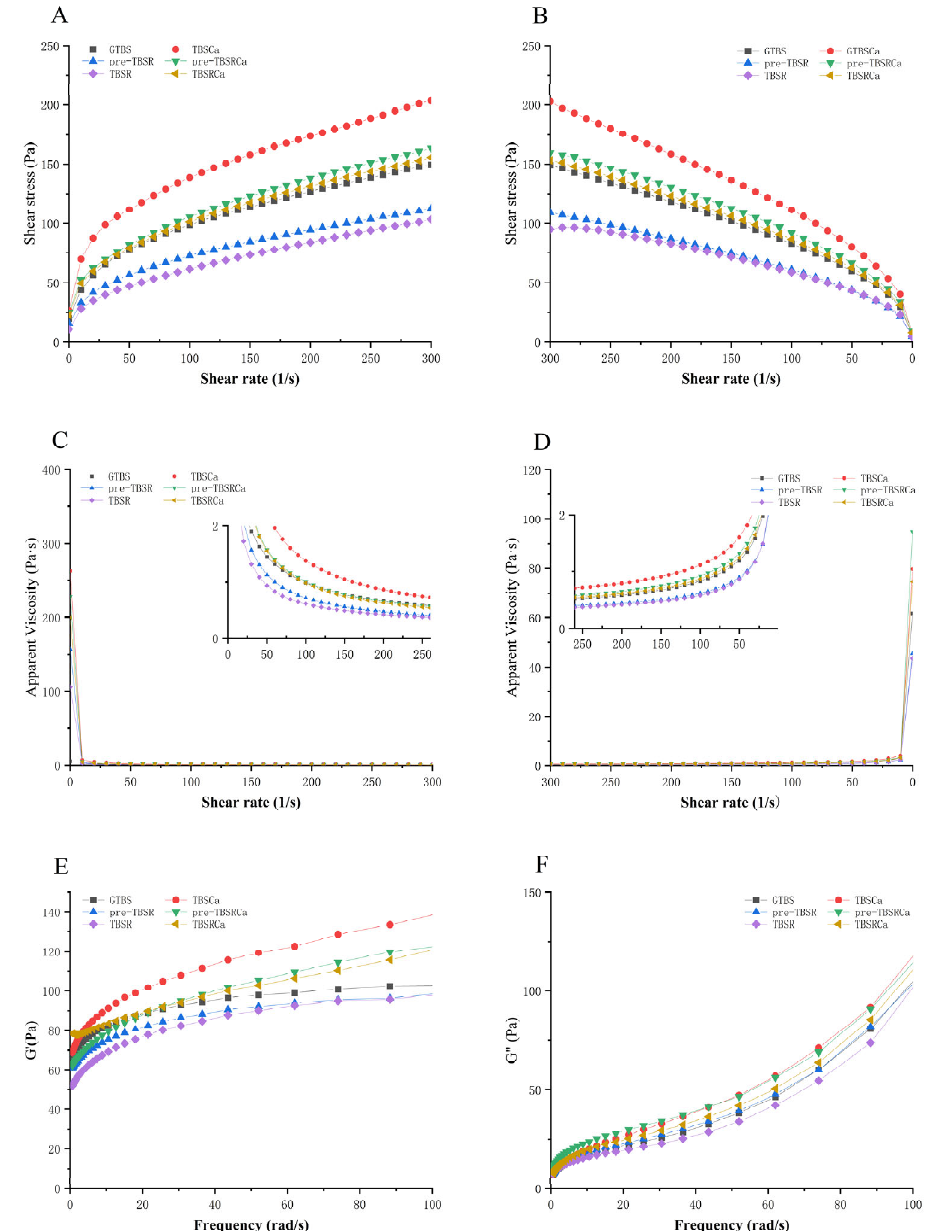
Figure 6. Upward ( A , C ) and downward ( B , D ) flow curves of samples; storage modulus G ′ ( E ); loss modulus G ″ ( F ).